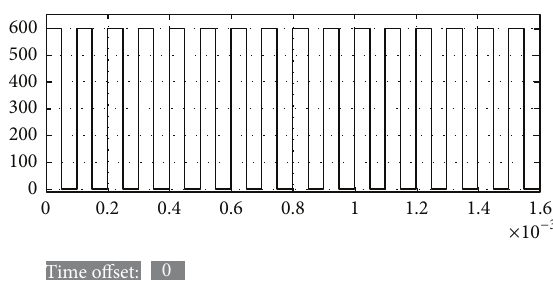
Figure 21: Control signals of switch 𝑆 3